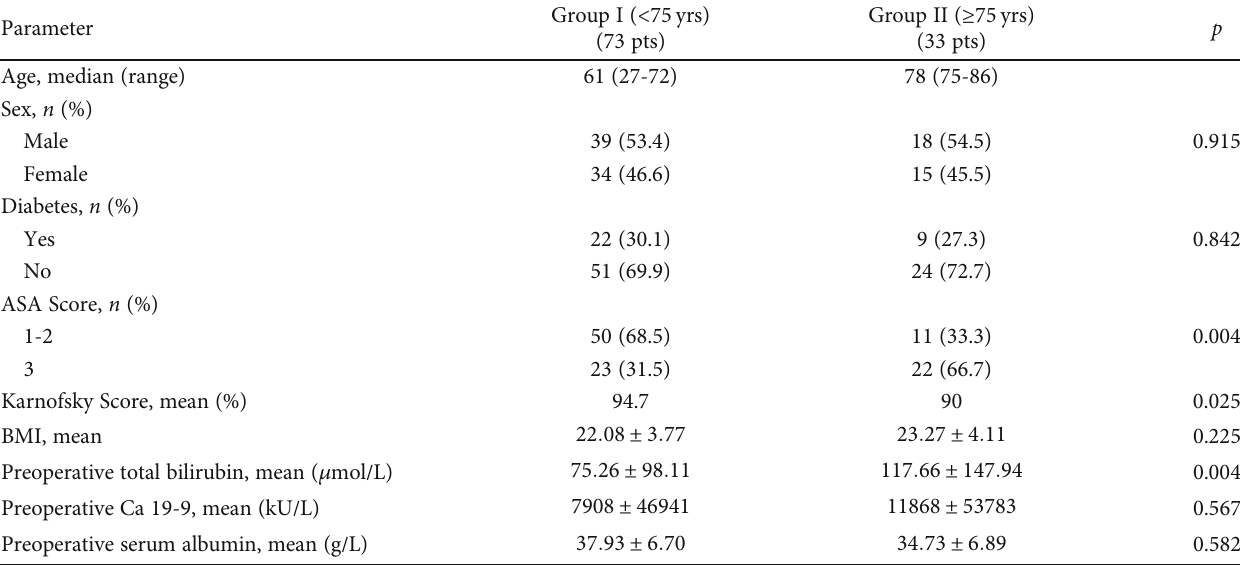
Table 1: Demographic and preoperative clinical data of 106